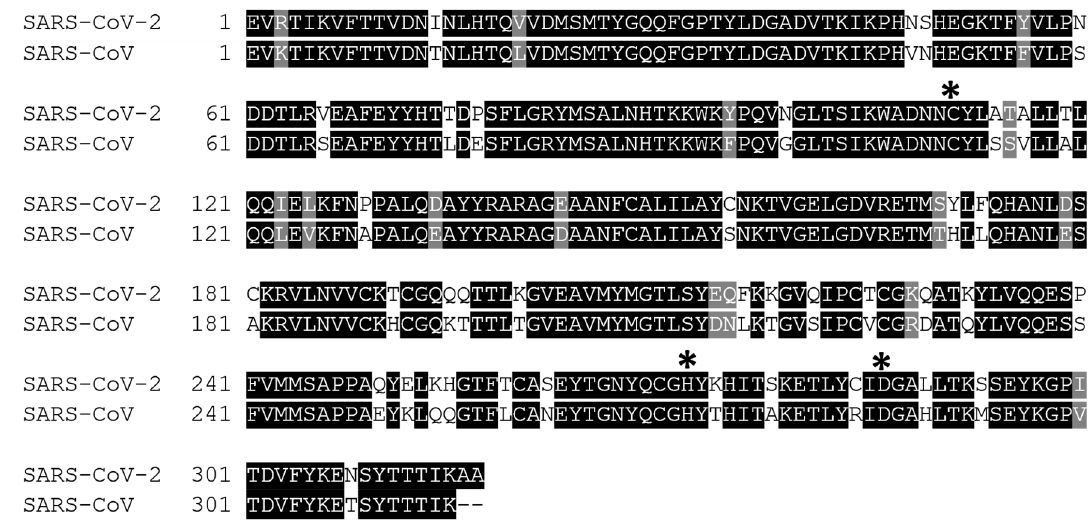
Figure 6. Multiple sequence alignment of PLpro between SARS-CoV-2 and SARS-CoV revealed that the sequences shared 83% sequence identity. The asterisk ( * ) indicates the shared catalytic residues of cysteine (C), histidine (H) and aspartic acid (D).